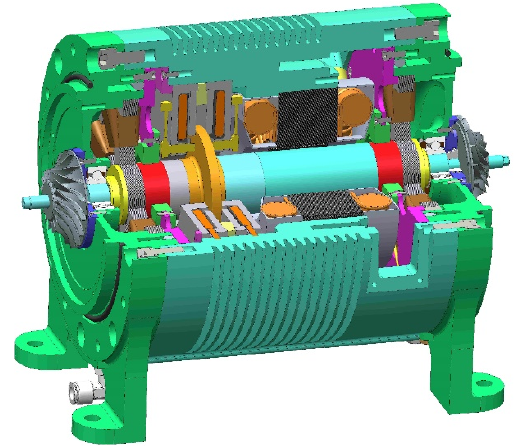
Figure 1. Structure of a high-speed and high-power-density maglev motor.